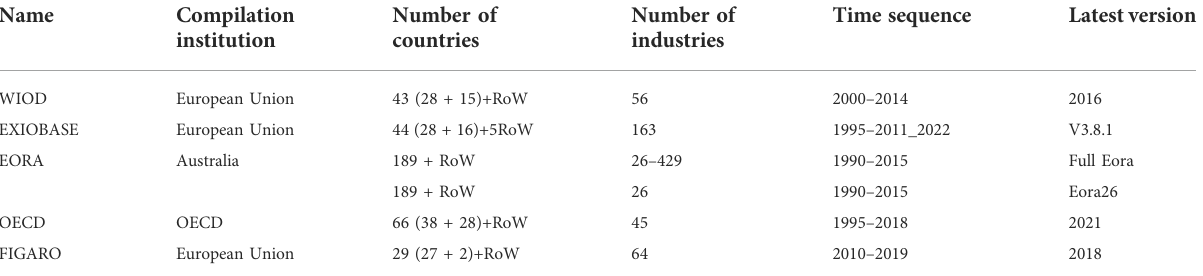
TABLE 3 The fi ve typical multi-regional input-output tables in the